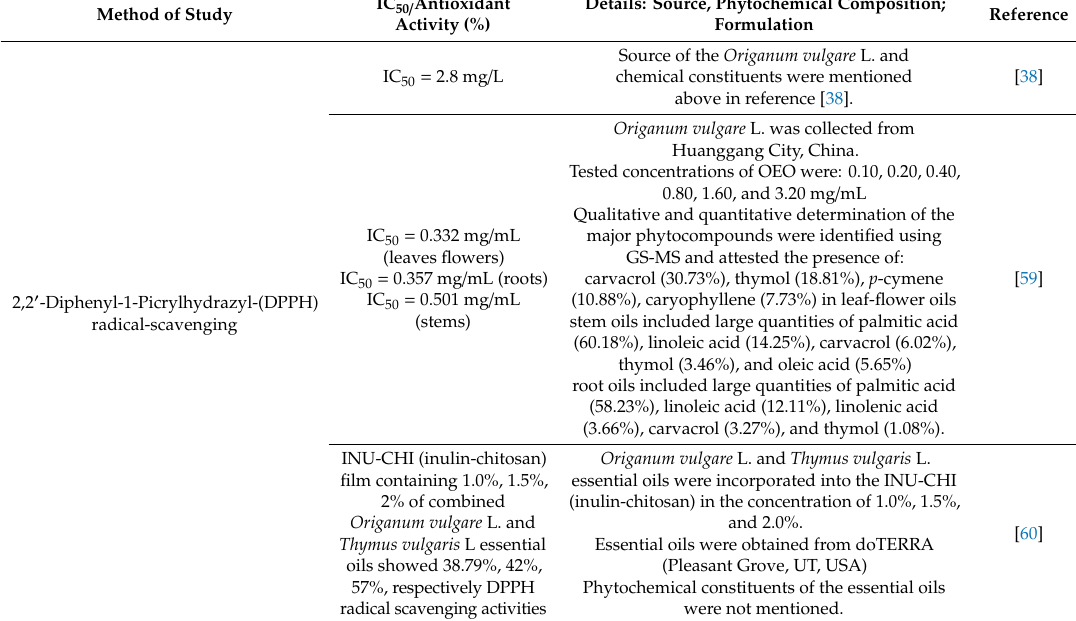
Table 5. Antioxidant activity of Origanum vulgare L. essential oil (OEO). Method of